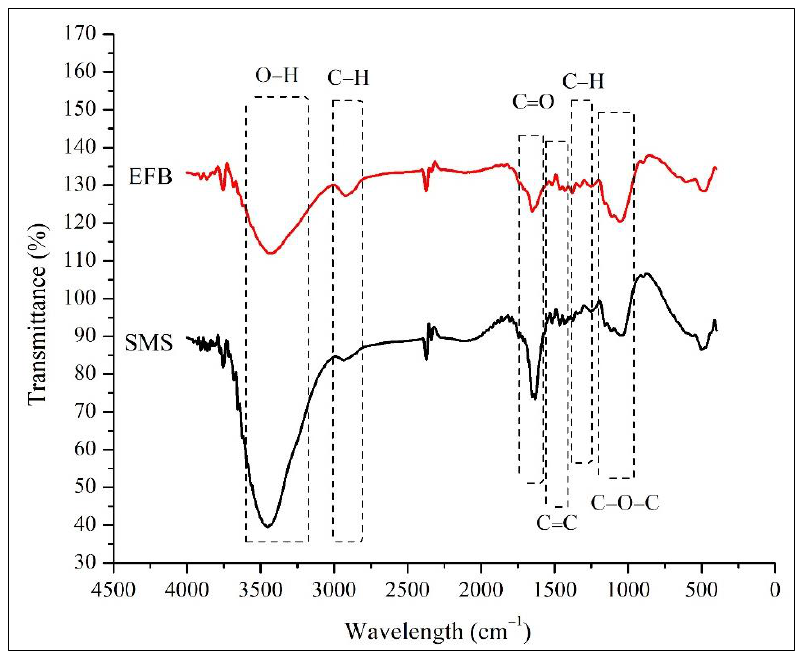
Figure 4. The FTIR trend peaks and intensity on each functional group to indicate chemical composition in the SMS, FRS, and EFB fibers. tion in the SMS, FRS, and EFB